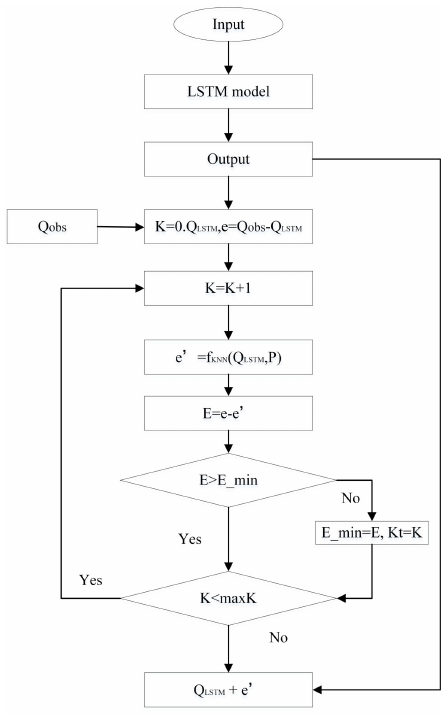
Figure 4. LSTM-k-nearest neighbor (KNN) model flow chart.